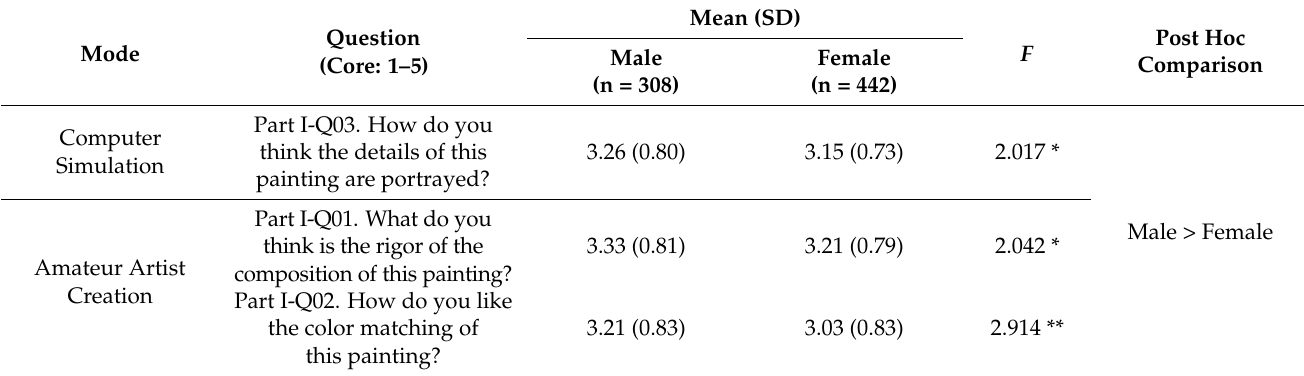
Table 6. The cognitive differences between audiences of different genders.